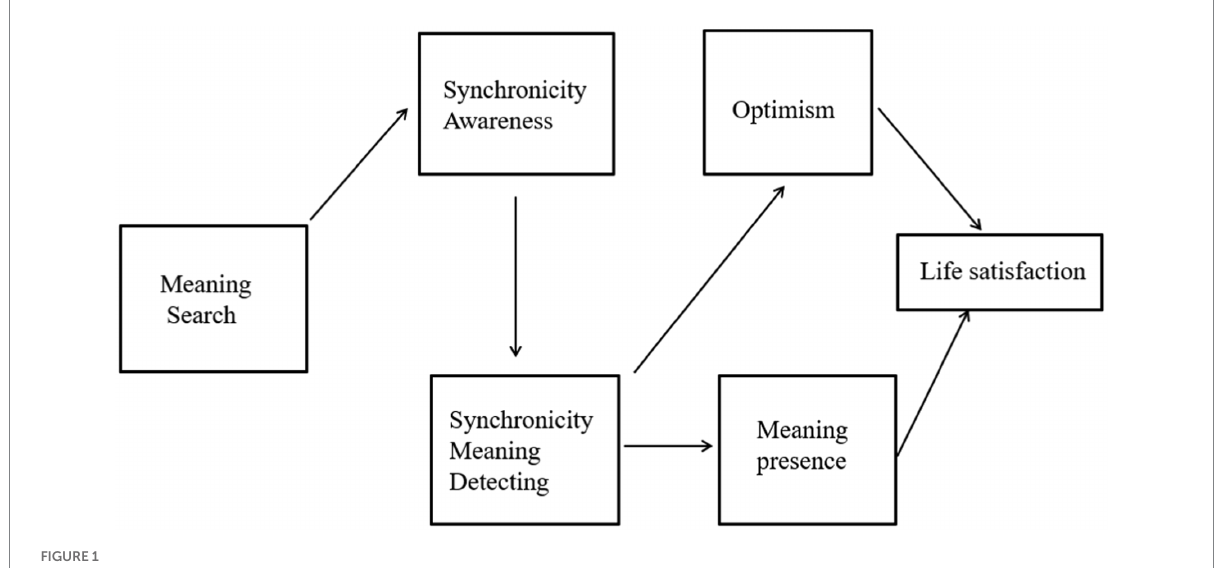
FIGURE 1 The proposed theoretical